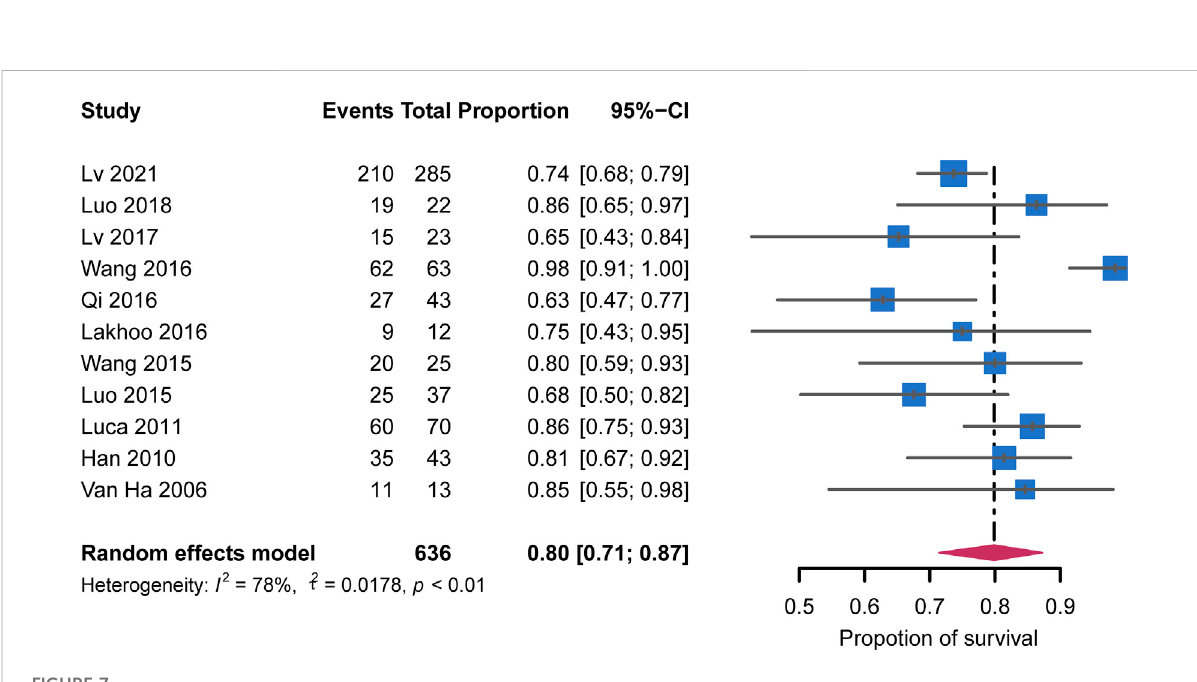
FIGURE 7 Forest plots for pooled rates of